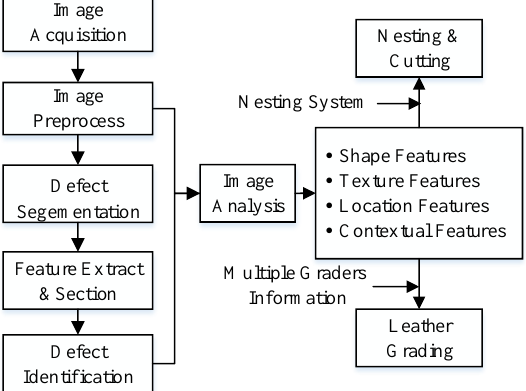
Figure 1. Overall pipeline for the leather visual defect inspection system.